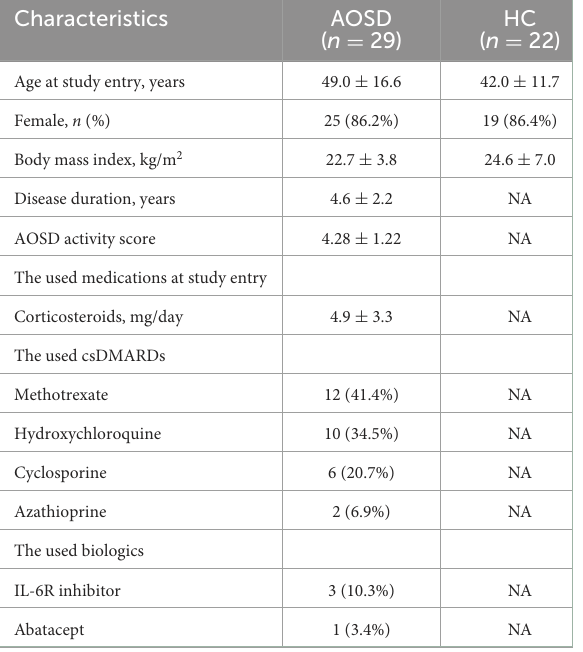
TABLE 1 Demographic data, disease activity scores, and the used medications in AOSD patients and healthy control (HC) subjects # . Characteristics